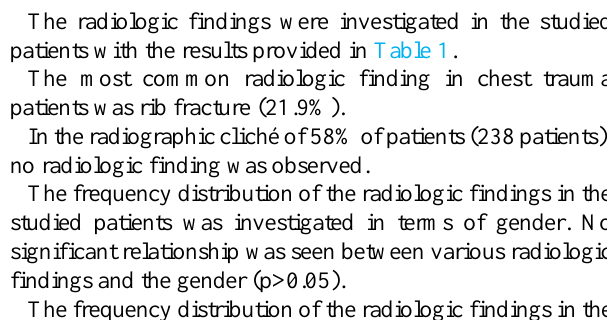
Table 1. Radiologic findings among injured travelers